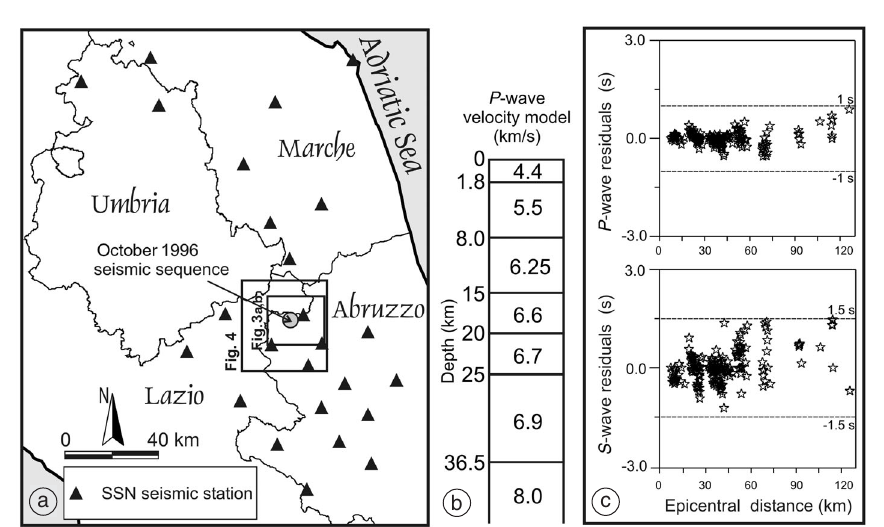
a b c Fig. 2a-c. a) Seismic stations of the Servizio Sismico Nazionale network in the Abruzzo, Marche, Lazio and Umbria regions that provided the recordings of the October 1996 sequence; all the stations were three-compo- nents (Lennartz Mars88 digital) and equipped with Mark L-4C 1 Hz seismometers; b) 1D velocity model used for hypocentral location; c) distribution of P - and S -wave residuals versus epicentral distance for the 1996 seis- mic sequence.